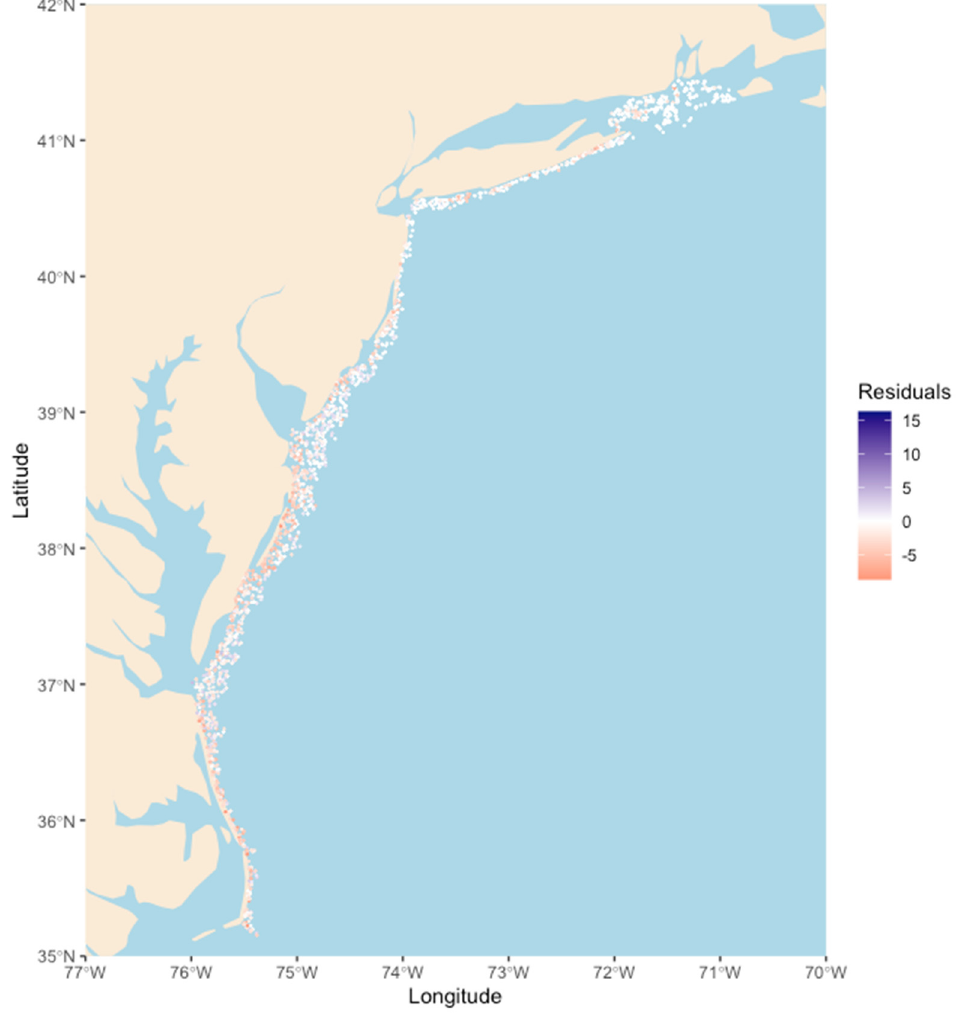
Figure A1. Map of residuals from delta GLM fitted to NEAMAP weakfish survey data. Blue indicates positive, red indicates negative, and color darkness is proportional to the value of residuals.